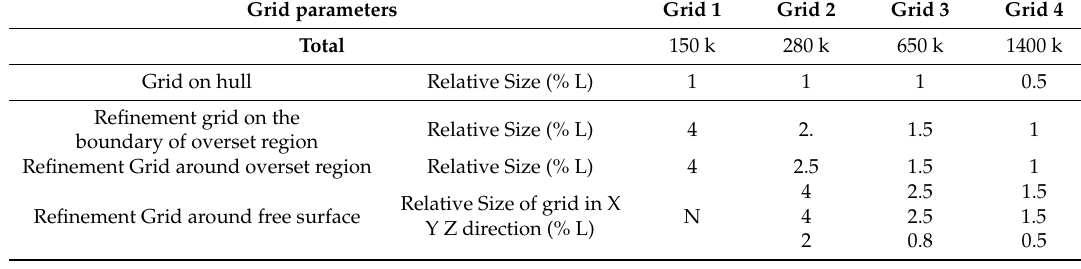
Table 4. Size of the grid.